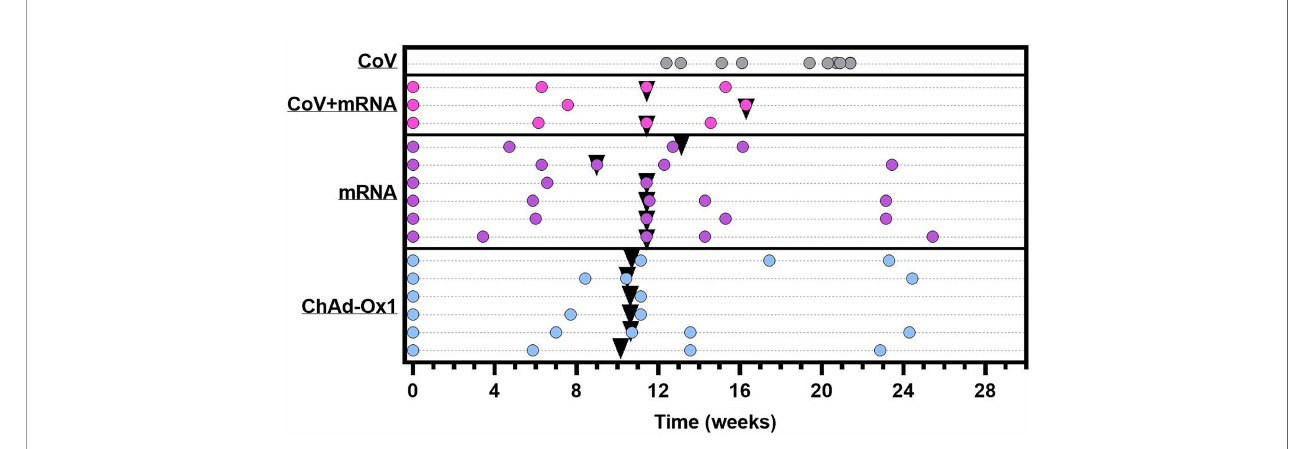
FIGURE 1 | Graphical representation of sample collection and vaccine administration. CoV+mRNA (pink dots) = seropositive adolescents receiving mRNA vaccination (n = 3) mRNA (purple dots) = seronegative adolescents receiving mRNA vaccination (n = 6). ChAdOx1 (blue dots) = seronegative adolescents receiving ChAdOx1 vaccination (n = 6). CoV (grey dots) = naturally infected adolescents with de fi nitive PCR results, for comparison (n = 10). Each dot represents a sample collection. Black triangles indicate time of second dose. Time for all vaccinated donors is relative to administration of fi rst dose. Time of blood sampling for naturally infected donors (CoV) is relative to the date of